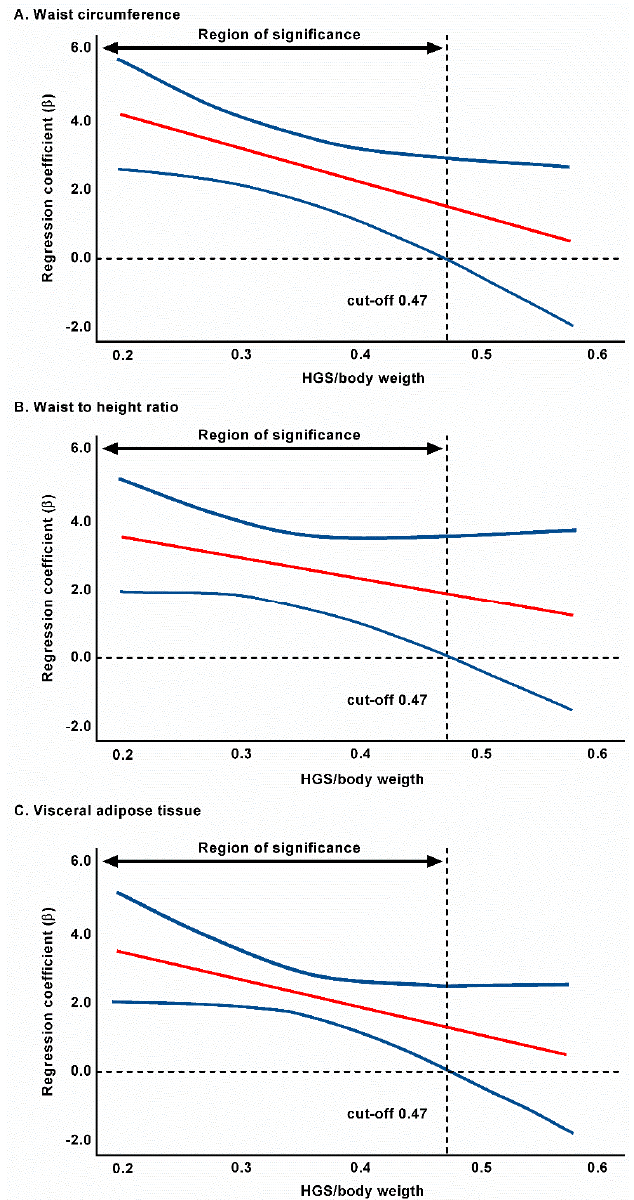
Figure 1. Regression slope estimate and 95% confidence interval for the relationship between anthropometric and body composition parameters and controlled attenuation ( A ), waist circumference; ( B ), waist to height ratio; and ( C ), visceral adipose tissue, as a function of HGS/weight, (moderator), based on Johnson-Neyman results. HGS, handgrip